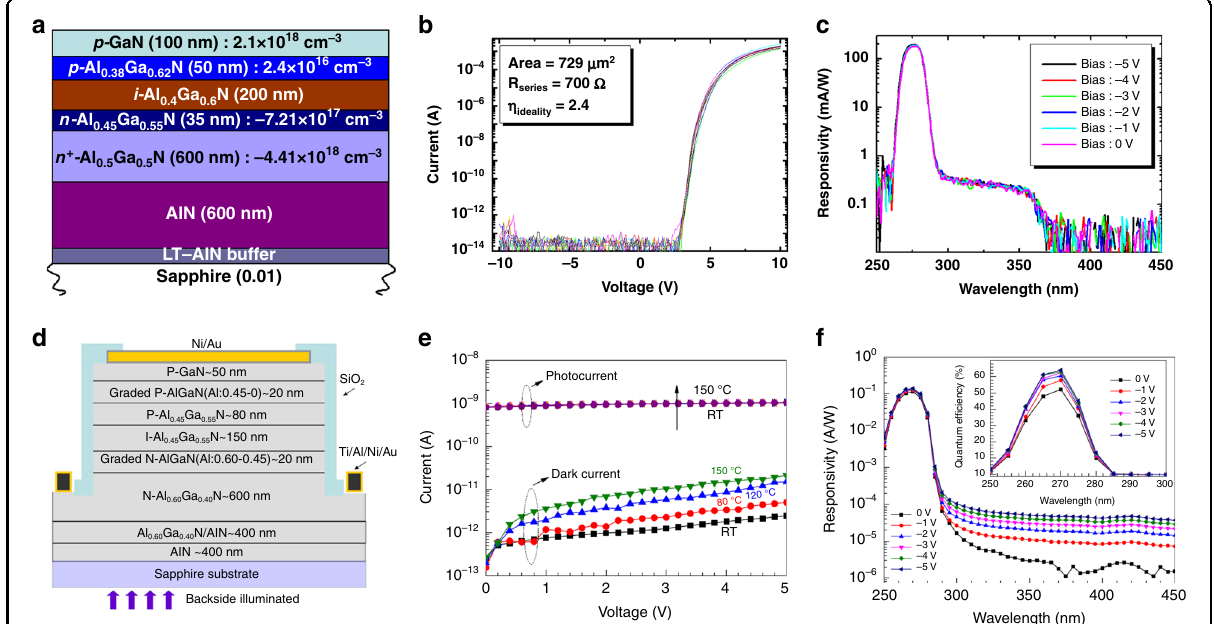
Fig. 13 Structures and performance of AlGaN p-i-n photodiodes. a Schematic cross-sectional structure of p-i-n AlGaN photodetector. b I-V curves of ten devices on the same wafer. Turn-on voltage is 5.6 V. The label shows series resistance and ideality factor. c Responsivity at different reverse biases. 176 mA/W under zero bias and 192 mA/W at 5 V. Reprinted with permission from Cicek et al. 199 . Copyright 2013 AIP Publishing LLC. d Schematic cross-sectional structure of the photodetector. e I-V curves at different temperatures. f Responsivity at various biases. The inset illustrates quantum ef fi ciency in the wavelength range from 250 to 300 nm. Reprinted with permission from Wang et al. 200 . Copyright 2012 Chinese Physical Society and IOP Publishing